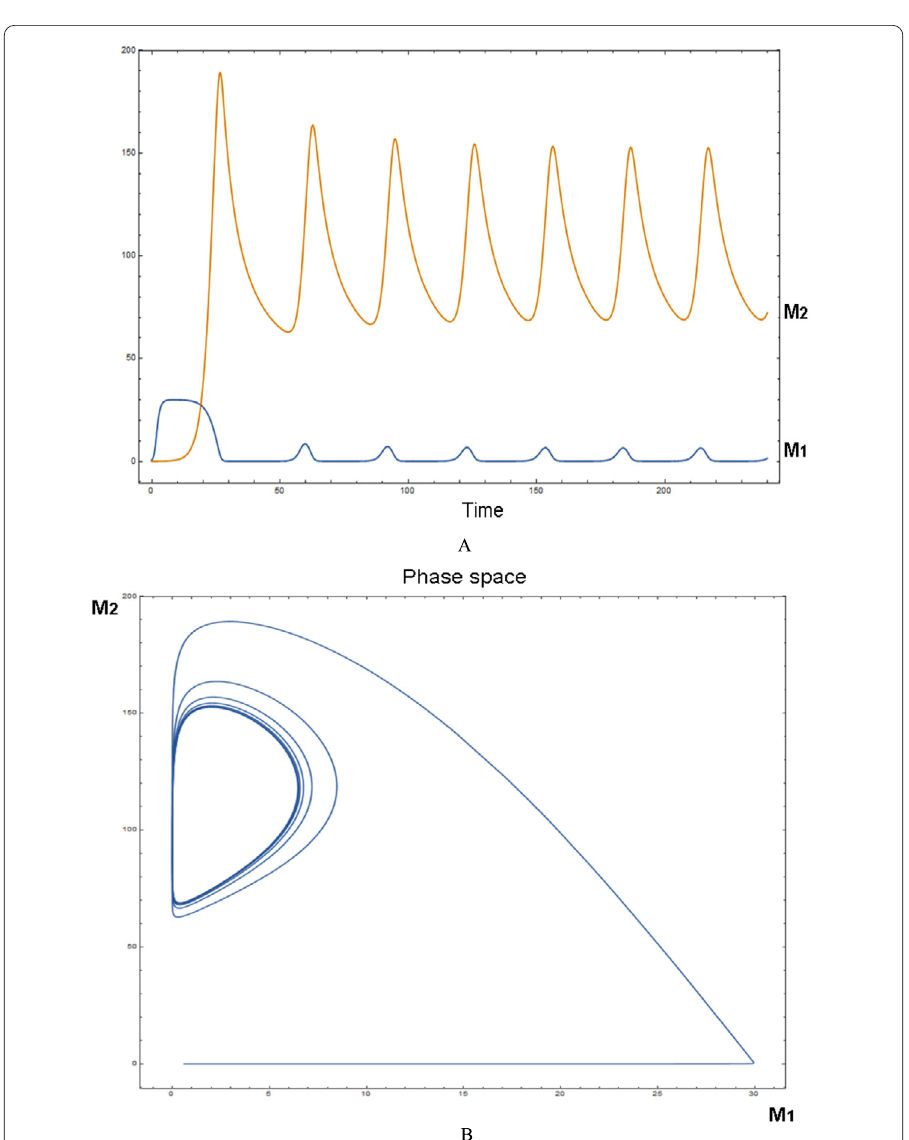
Figure 6 Time series showing the existence of periodic solutions at the vicinity of the steady state equilibrium giving birth to a stable limit cycle in A and the phase portrait in B for M 1 (0) = 0.6, M 2 (0) = 0.02, a 1 = 0.07, b 1 = 0.039, V = 30, a 2 = 0.023, b 2 = 0.06, a 3 = 0.13, n = 0.49, m =